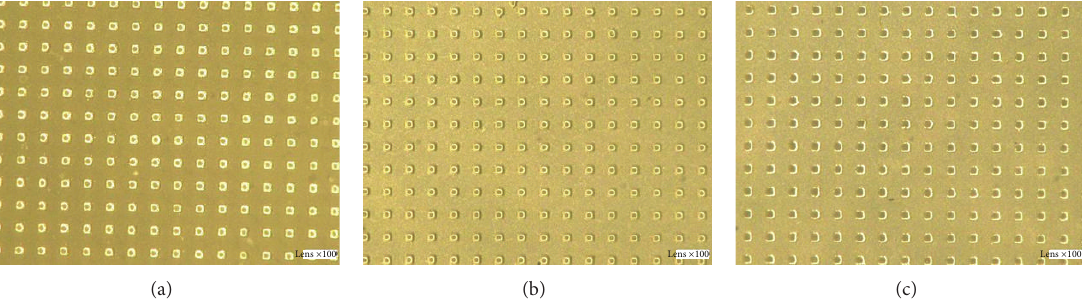
Figure 13: Optical micrographs of focus points of the microlens arrays ( × 100) (a) PMMA, (b) PS, and (c)